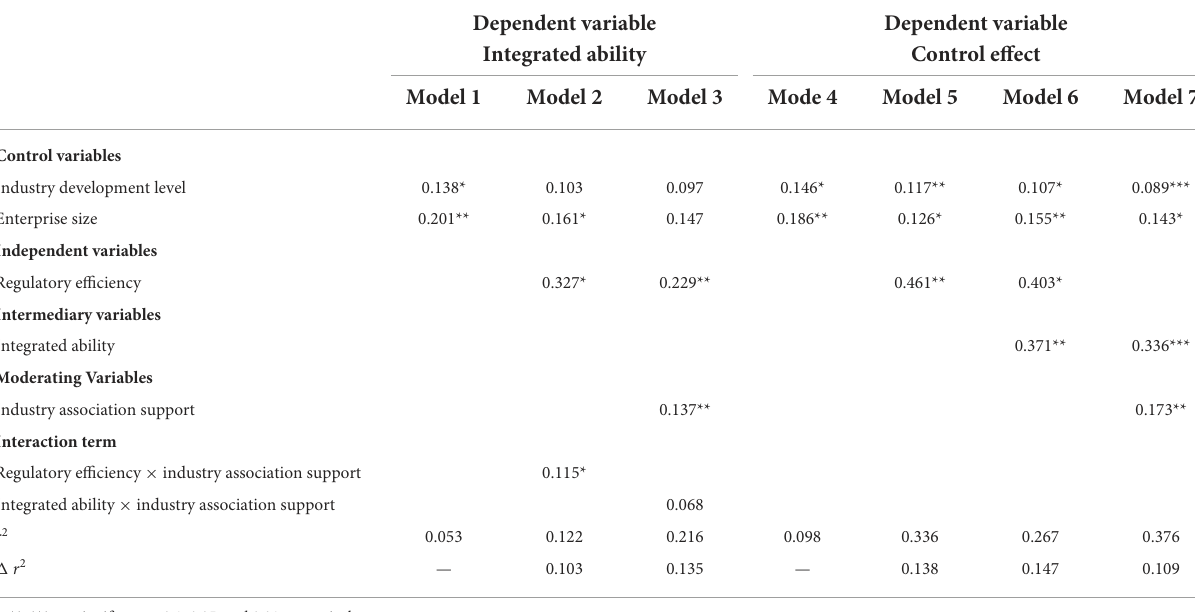
TABLE 7 Stepwise regression results.